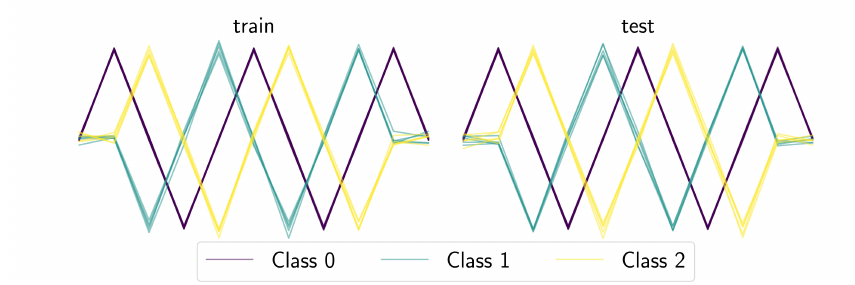
Figure 9. The generated training and test set for the artificial classification problem.